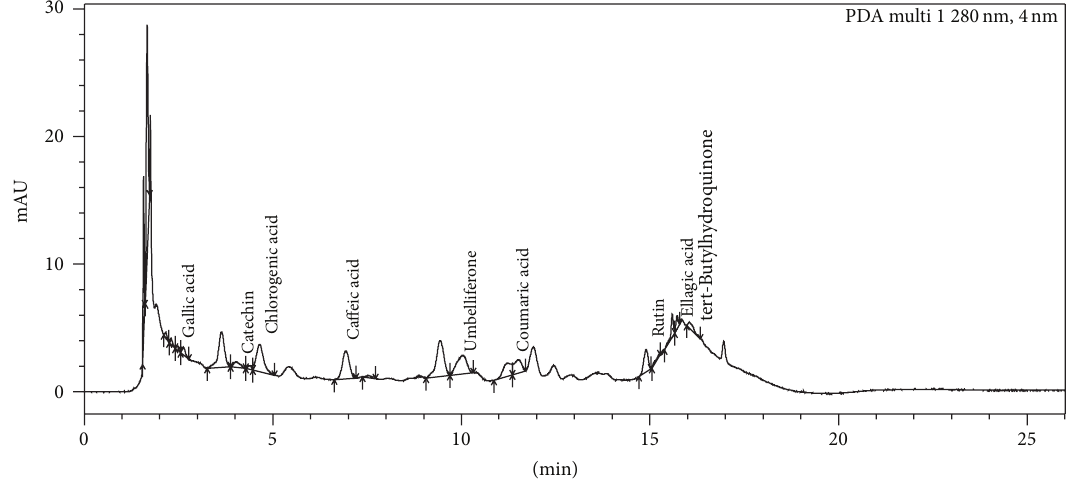
Figure 8: Chromatogram showing the presence of various types of polyphenols in the aqueous extract of P. aculeata L.